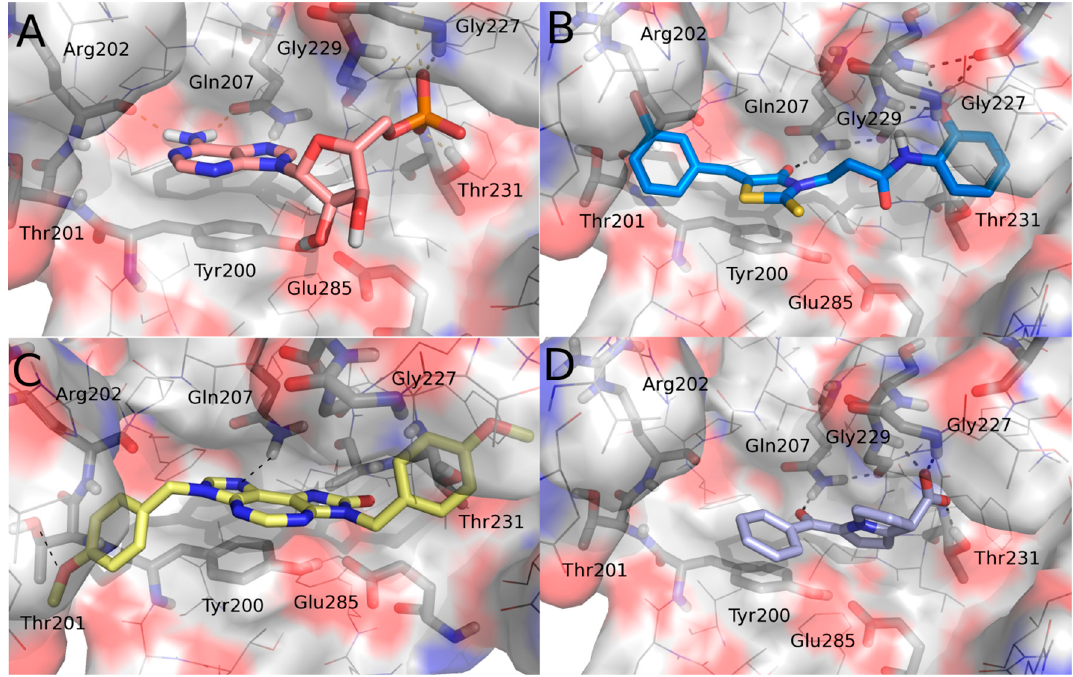
Figure 2. Binding poses of ( A ) AMP (salmon), ( B ) FE15 (blue), ( C ) RK - 33 (yellow), and ( D ) ketorolac (periwinkle) into the ATP pocket of human DDX3. For the sake of clarity, only a few key residues are labeled, hydrogen atoms are omitted, and hydrogen-bonding interactions are represented by black dashed lines. Compounds and key amino acids are in stick representation.